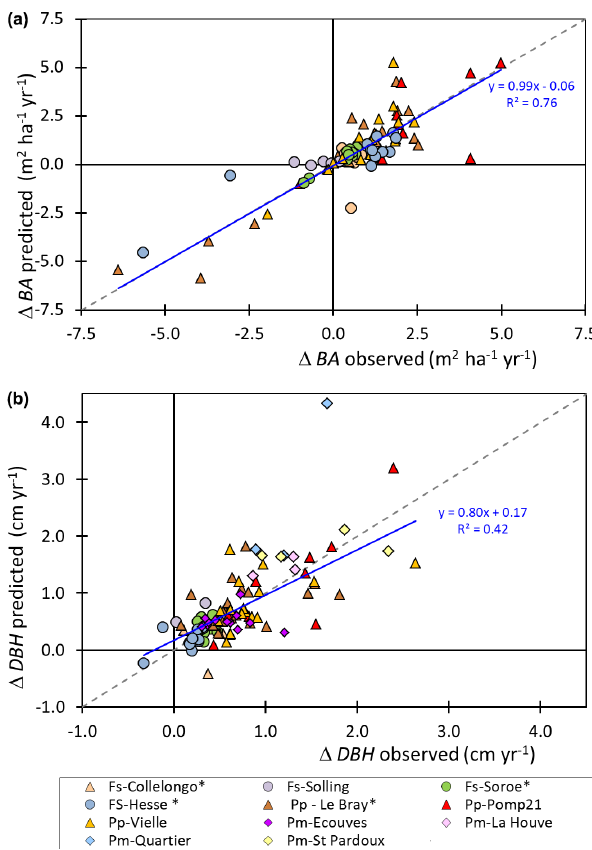
Figure 13. Predicted versus observed values of annual increment in basal area, (cid:49) BA (a) , and stem mean diameter, (cid:49)D 130 (b) , for sites described in Table S6 in the Supplement. The sites used for both flux and inventory data are annotated with a star (*). The 1 : 1 line (dashed line) and linear regression (blue) are